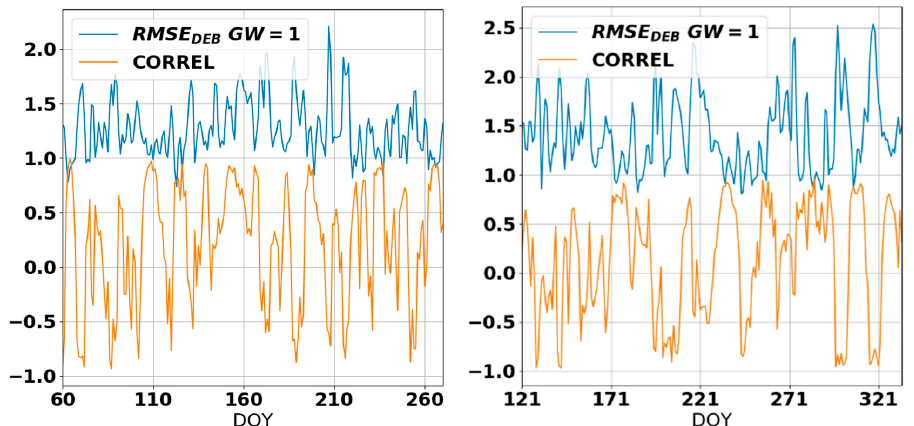
Table 2. Mean bias, mean bias uncertainty, and mean RMSE for all gap widths in selected